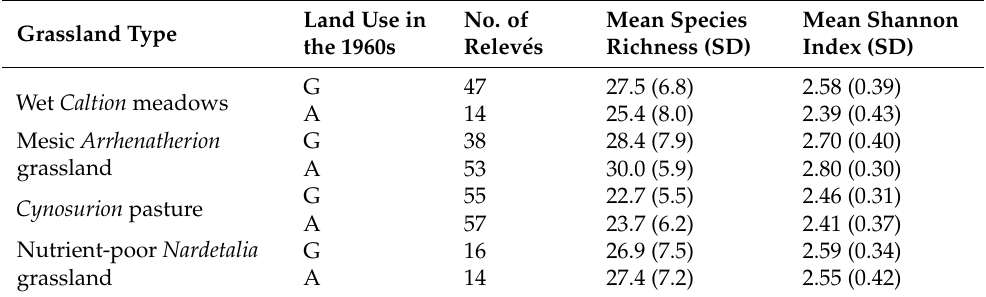
Table 2. Diversity of grassland types in relation to land use in the past. Land use in the 1960s: G-grassland; A-arable fields.